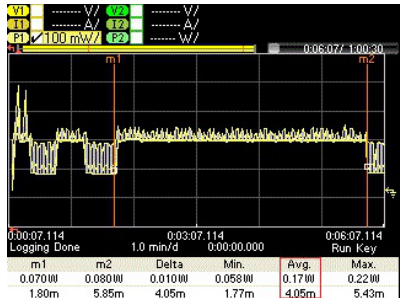
Figure 12. The energy consumed for transmitting an original image is ( a ) 0.0357 Wh and for trans-